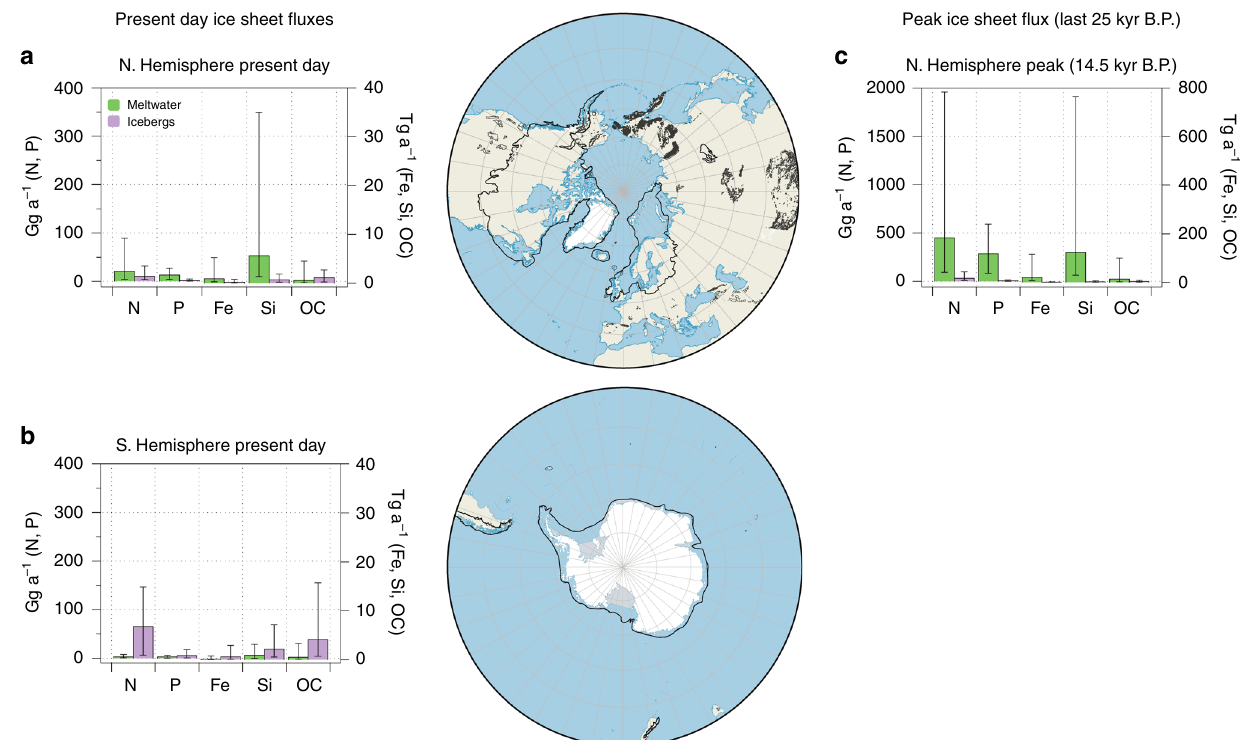
Fig. 2 Fluxes of nutrients and organic carbon. Fluxes of bioavailable nutrients and organic carbon associated with subglacial meltwater and ice discharge from ( a ) northern and ( b ) southern hemisphere ice sheets at the present day and ( c ) northern hemisphere ice sheets during Meltwater Pulse 1a (14.5 kyr B.P.). LGM extents of ice sheets in both hemispheres are indicated by a black line in the maps. Nutrient fl uxes and their uncertainty refer to the following species: N = DIN + loosely sediment bound NH 4 + (also including loosely bound NO 3 − for icebergs), P = DIP + bioavailable sediment bound P (MgCl 2 -P + NaOH- P), Fe = DFe (<0.02 μ m) + CNFe (colloidal/nanoparticulate Fe, 0.02 – 0.45 μ m) + SSFe (sediment-bound ascorbic acid extractable nanoparticulate Fe, e.g., ferrihydrite), Si = DSi + ASi and OC = POC + DOC. All fl uxes include minimum, maximum and mid-range estimates calculated from published estimates of the range of nutrient concentrations and freshwater fl uxes. Please see Supplementary Methods for fl ux calculations, error bars and the full dataset (note the different y axis scales in Northern Hemisphere peak fl